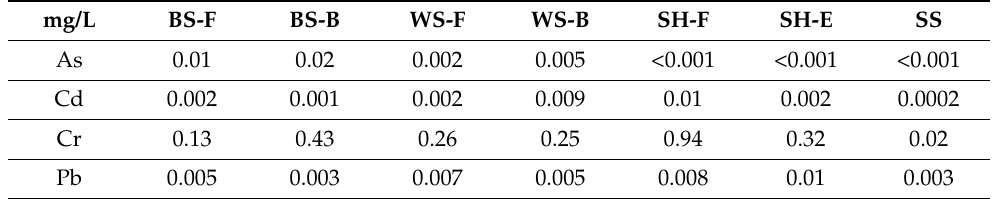
Table 7. Heavy metals leached out of ABAs.